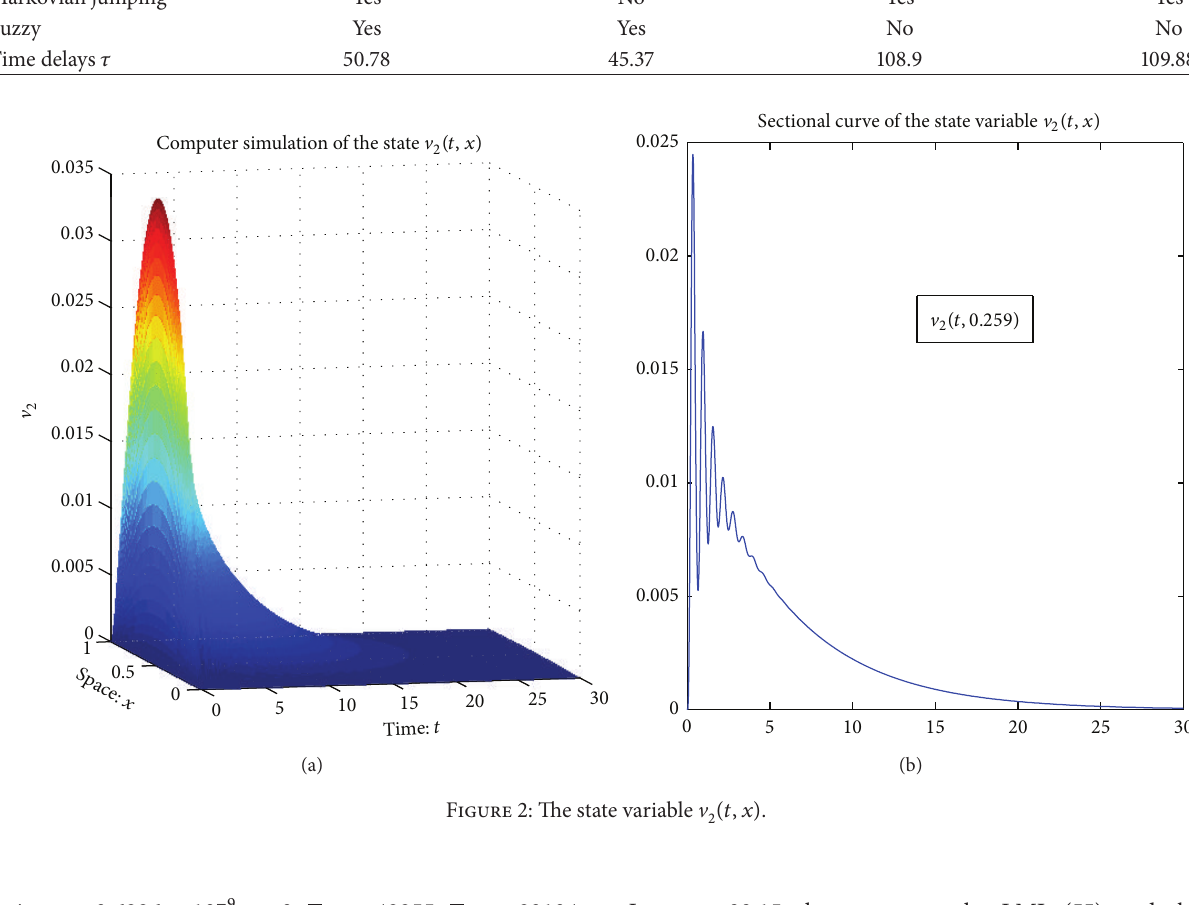
Figure 2: The state variable V 2 (𝑡,𝑥)